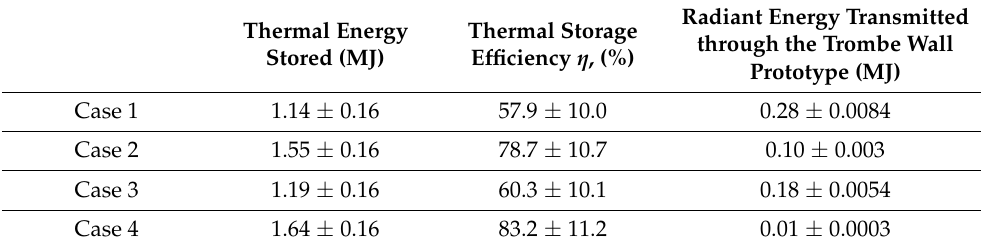
Table 2. Thermal energy stored, thermal storage efficiency, and radiant energy transmitted for the four Trombe-wall prototype cases